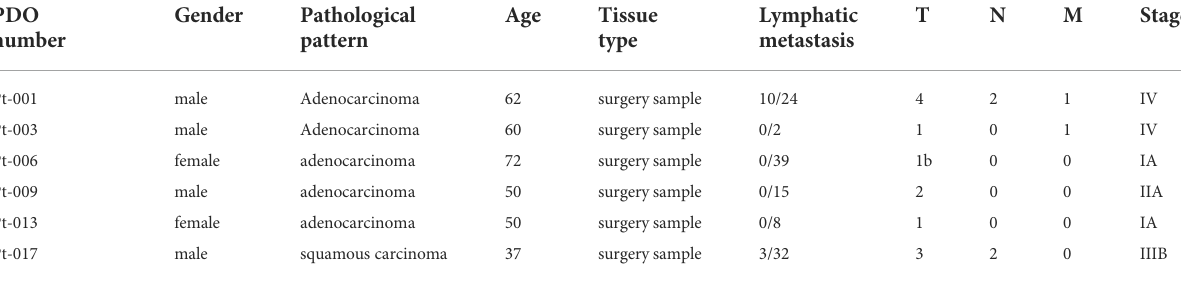
TABLE 1 Characteristics and clinical history of all patients included in the